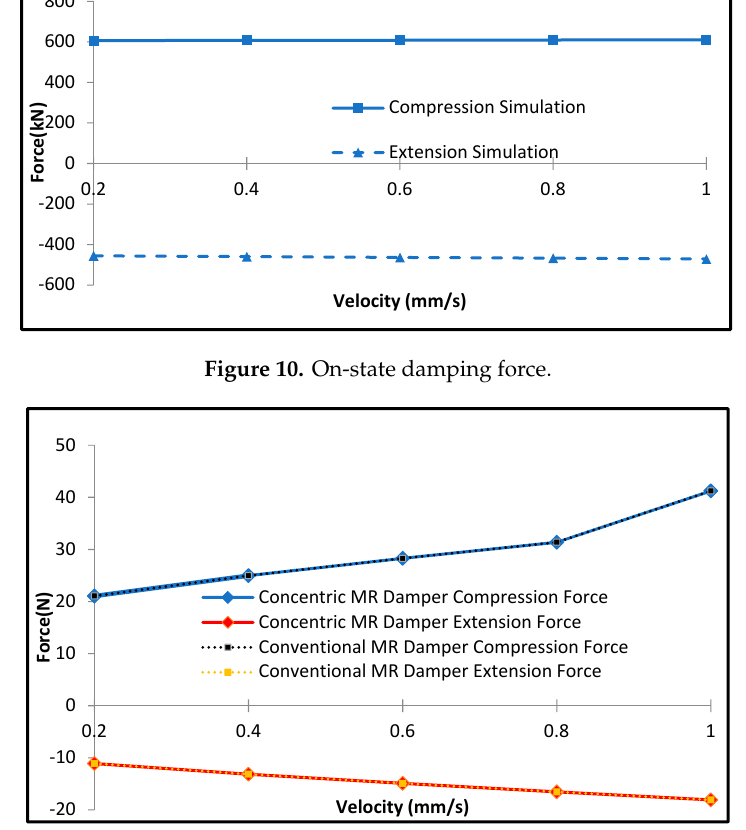
Figure 11. Damping force comparison between conventional and concentric MR dampers at zero magnetic field.